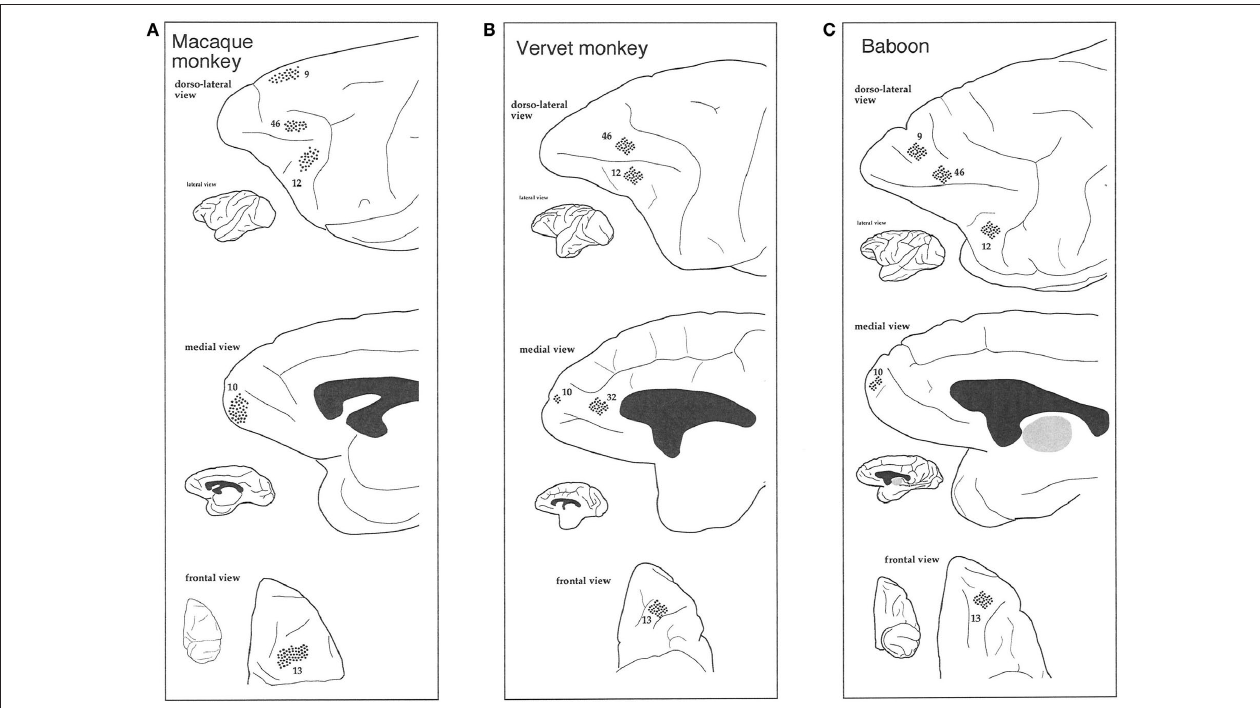
Figure 2 | Schematic illustrating where neurons were sampled (dots) in the dorsolateral, medial, and orbital prefrontal cortex of the macaque monkey (A), vervet monkey (B), and baboon (C).